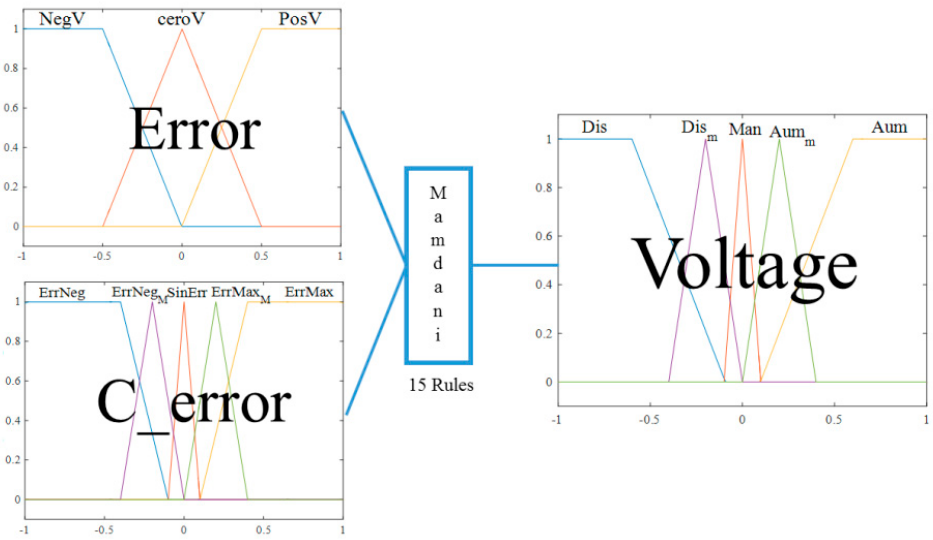
Figure 8. The structure of the fuzzy controller of the Motor.